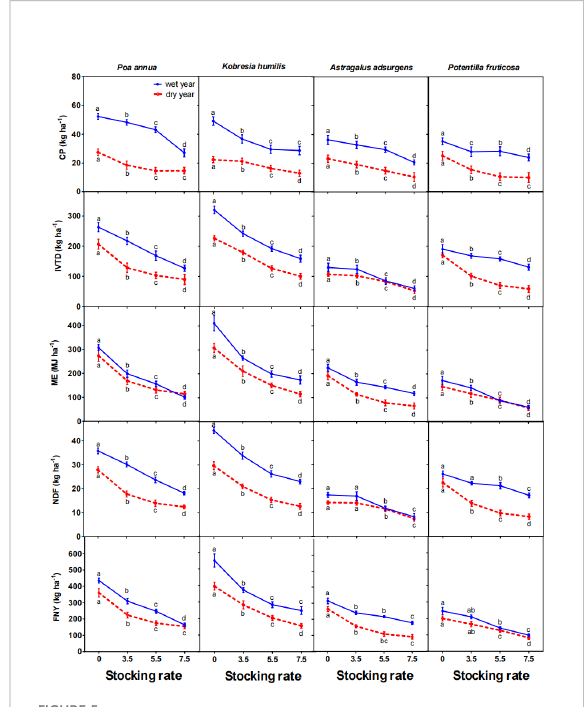
FIGURE 5 Effects of stocking rate on forage nutritive yield (FNY), crude protein (CP) yield, in vitro true digestibility (IVTD), metabolizable energy (ME), neutral detergent fi ber (NDF) and forage nutritional value (FNV) yield of four dominant species in a wet year (2019) and a dry year (2020) (means ± standard error). Means with different letter in the same year differ from each other (P<